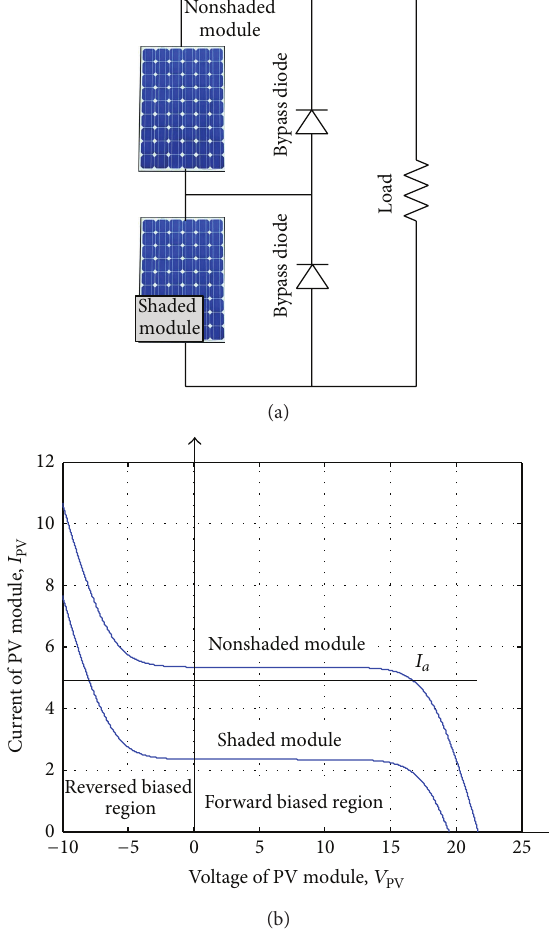
Figure 2: (a) PV array under partial shading conditions (b) 𝑃 - 𝑉 curve of PV